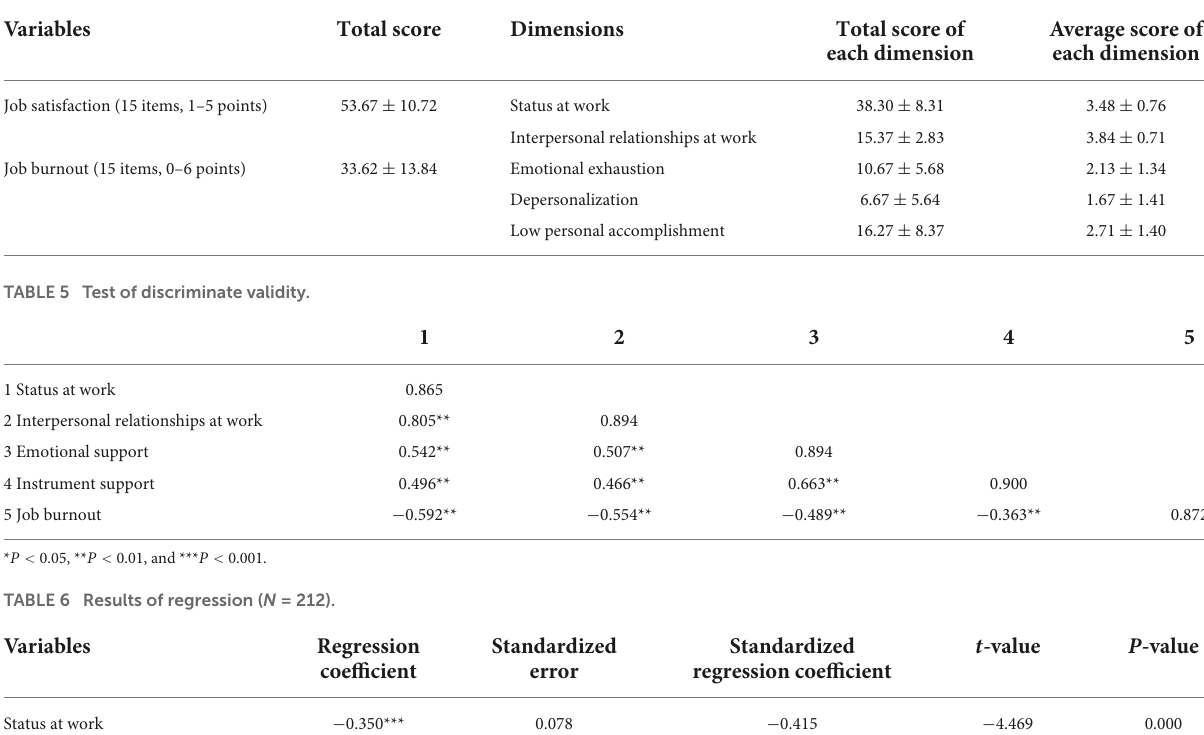
TABLE 4 Descriptive statistics.